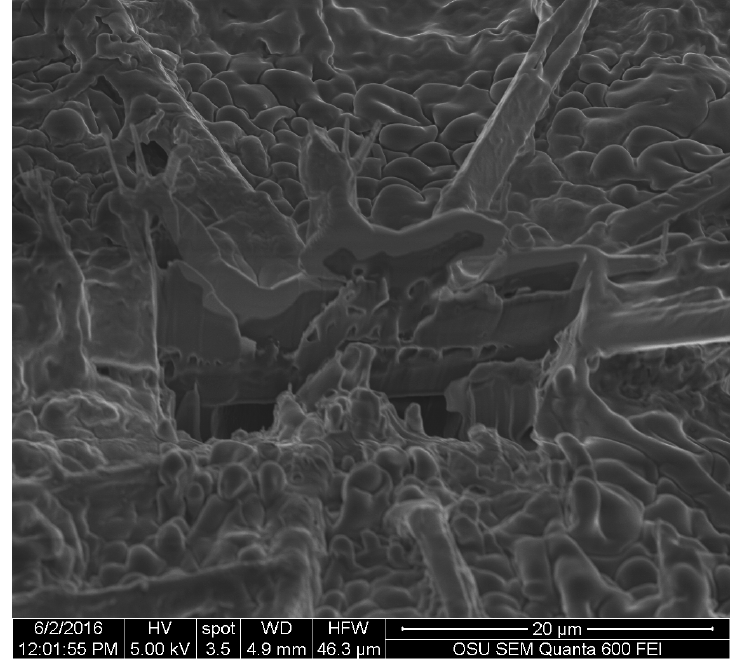
Figure 11. Cross-section of a crystal-like structure produced by S. cuboideum on cottonwood, showing void spaces between the attachment area of the pigment with the wood cell wall. Picture taken with an FEI QUANTA 3D dual beam SEM/FIB.